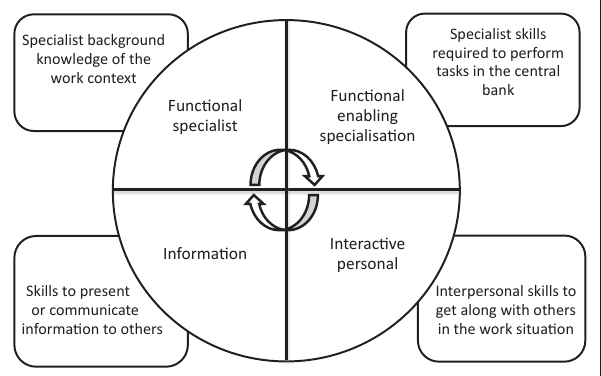
FIGURE 5: Phase 1: The competency clusters of the proposed central banker competency model as constructed by the researchers.